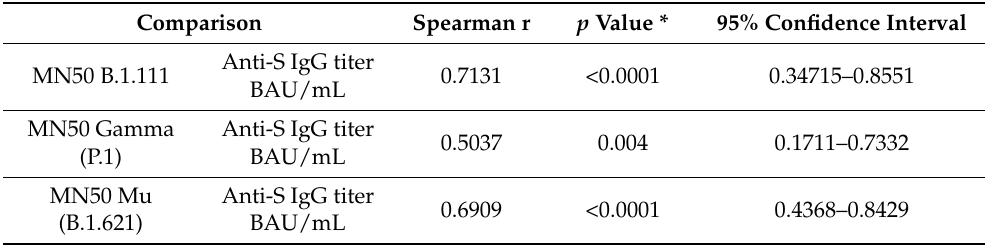
Figure 2. Neutralizing titers of BNT162b2-vaccinated volunteers against Mu, Gamma, and B.1.111 SARS-CoV-2 isolates. TCID50-based assays were performed by incubating 120 TCDI50 of each SARS-CoV-2 isolate with five two-fold serial dilutions of sera from BNT162b2-vaccinated volunteers. The MN50 titer was calculated by the Reed–Muench method. Statistical differences between the median values of MN50 titers against Mu, Gamma, and B.1.111 variants were determined using the Kruskal–Wallis test, followed by Dunn’s post hoc test for multiple comparisons. An arbitrary MN50 titer value of 2 was assigned to the 11 out of 31 serum samples that do not neutralize the virus at the lowest dilution (1:4). Abbreviations. n : number of samples, GMT: geometric mean titer, MN50: mean neutralizing antibody titer. Table 2. Comparison of MN50 titers and binding antibody